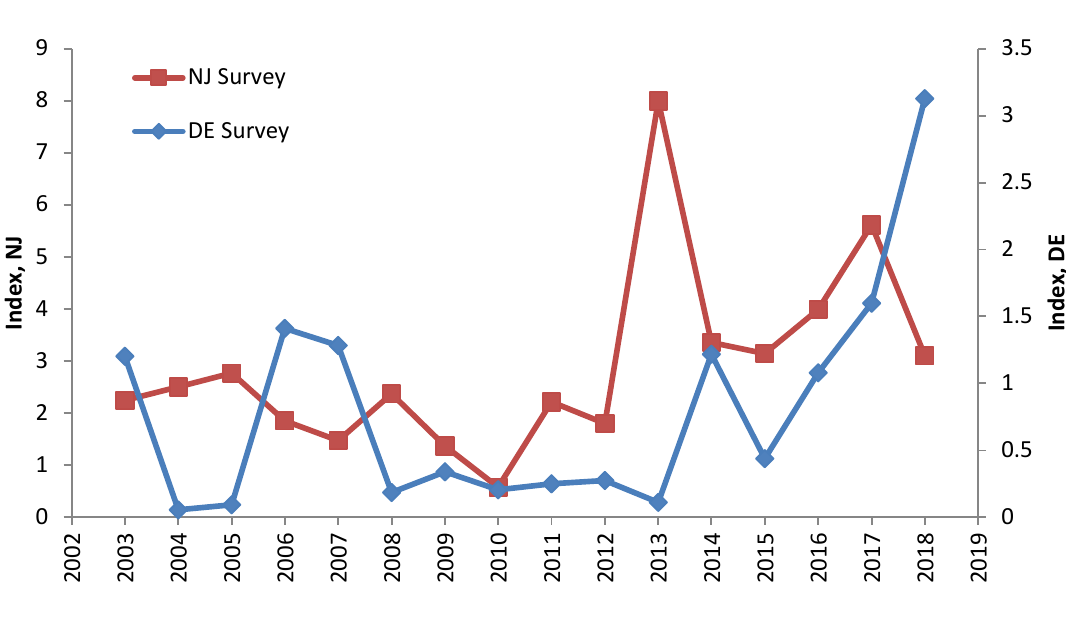
Figure 96. Aggregate stage indices from the Delaware and New Jersey trawl surveys.